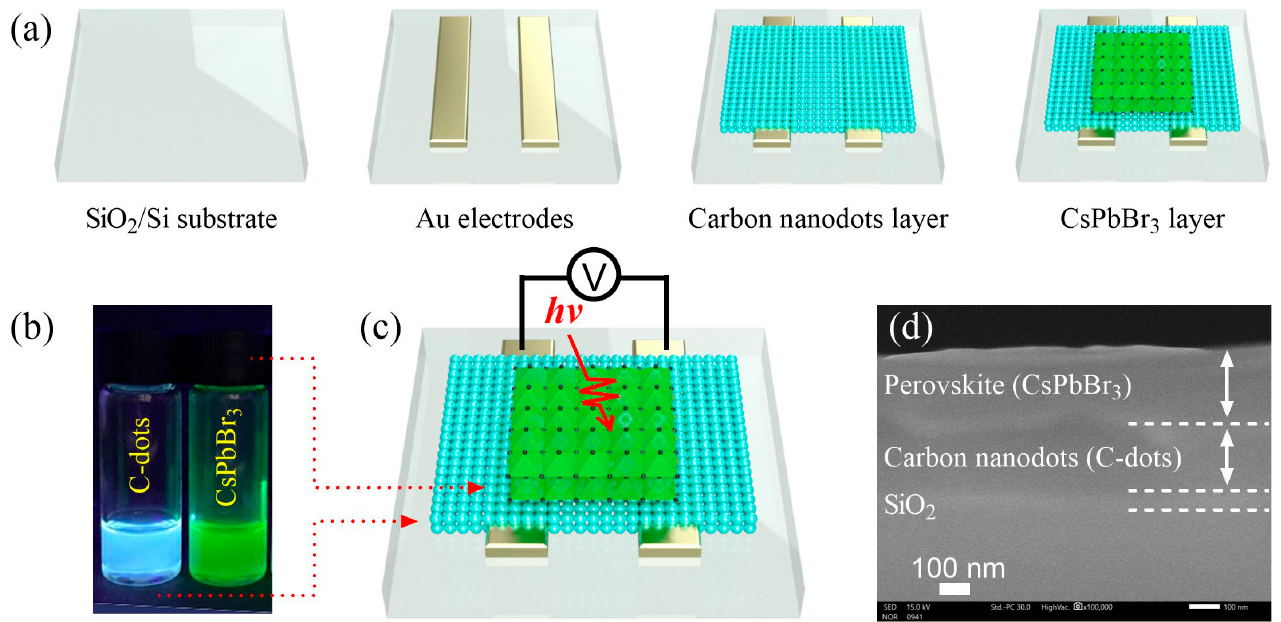
Figure 1. ( a ) A schematic for the fabrication process of C-dot/perovskite heterostructure PD. ( b ) An image of C-dot and CsPbBr 3 perovskite solutions under 365 nm UV light illumination. ( c ) A schematic structure of C-dot/CsPbBr 3 perovskite heterostructure PD. ( d ) A cross-sectional image of C-dot/CsPbBr 3 perovskite bilayer heterostructure deposited on a Si substrate with a 100 nm SiO 2 oxide layer.